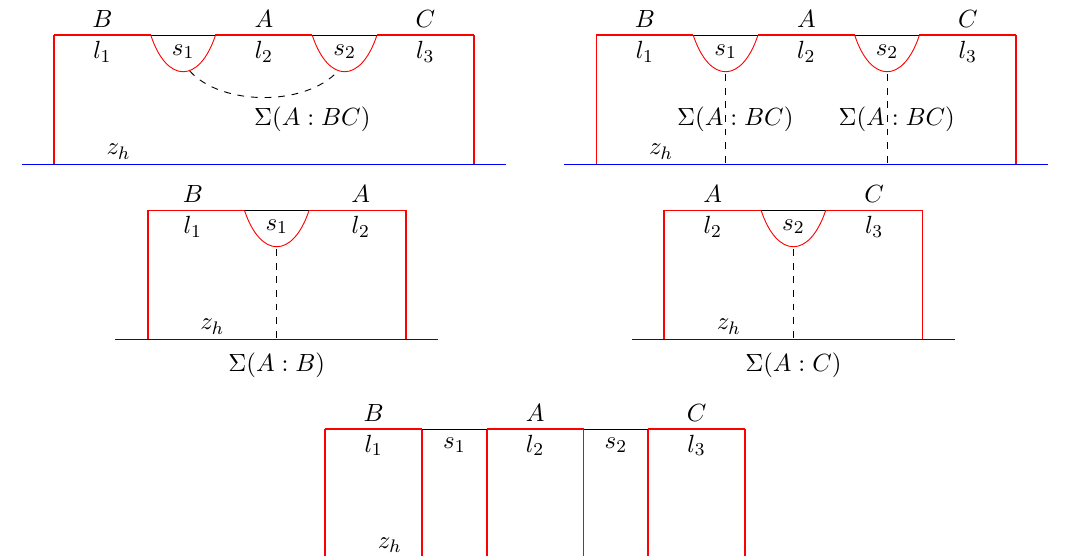
Figure 5 . Pictorial representations of the configurations in S C and S D phases, appearing in soliton geometries, for the case of three non-overlapping subsystems with A in the middle. Note that none of the surfaces really end on different points (all blue points at z are identified) but h they are connected t -embeddings. Top row : the tripartite configuration in the S phase. The C EWCS is obtained through the area of the Σ( A : BC ) (dashed curves) either from the standard single component configuration (left) or the double component configuration (right). Middle row : bipartite configurations in the S phase. The dashed curves in the left and right plots represent C Σ( A : B ) and Σ( A : C ) , respectively. Bottom row : the tripartite configuration in the S phase. No D EWCSs exist in this